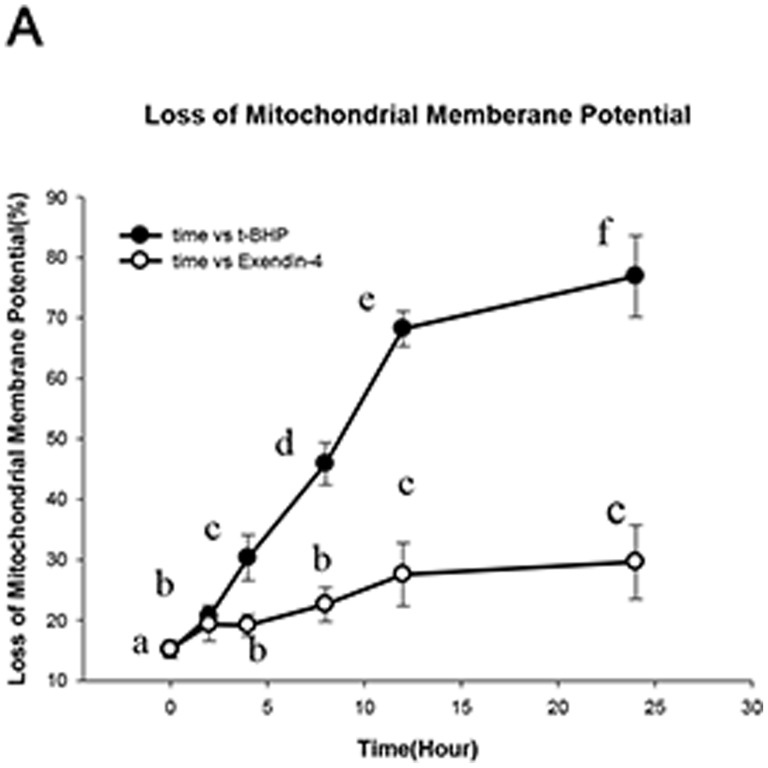
Exendin-4 prevents the loss of mitochondrial membrane potentials.An absorbance microplate reader was used to analyze the loss of mitochondrial membrane potentials. The figure shows the time course of the t-BHP-induced loss of mitochondrial membrane potential. The data are expressed as the means±S.D. (n = 6). a, b, c, d, e and f indicate the t-BHP groups and Exendin-4 groups at different intervention times (p<0.05).